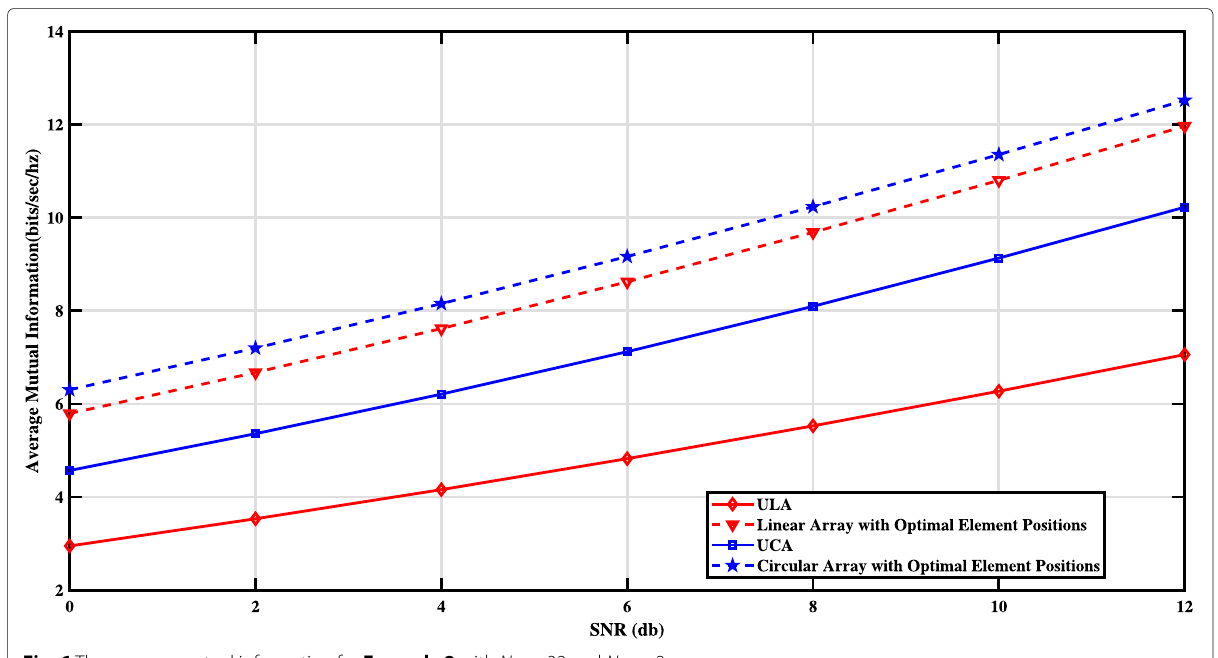
Fig. 6 The average mutual information for Example 2 with N B = 32 and N U = 2 coupling and spatial correlation problems in QOSTBC massive wireless MIMO communications.